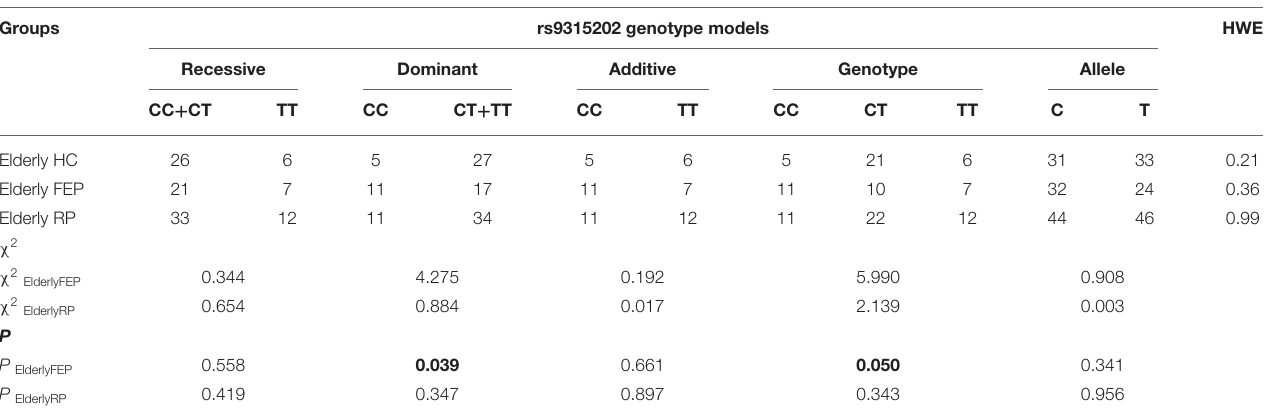
TABLE 2 | Genotyping and allele distributions of SNP rs9315202 in the elderly participants. Groups